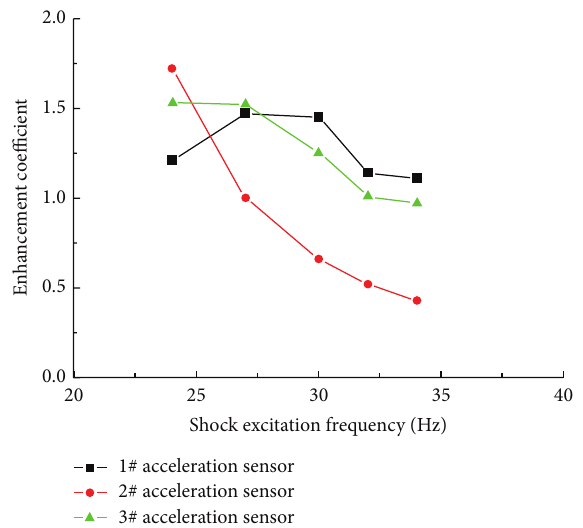
Figure 19: Enhancement coefficient curve of the acceleration response (0.75 g).